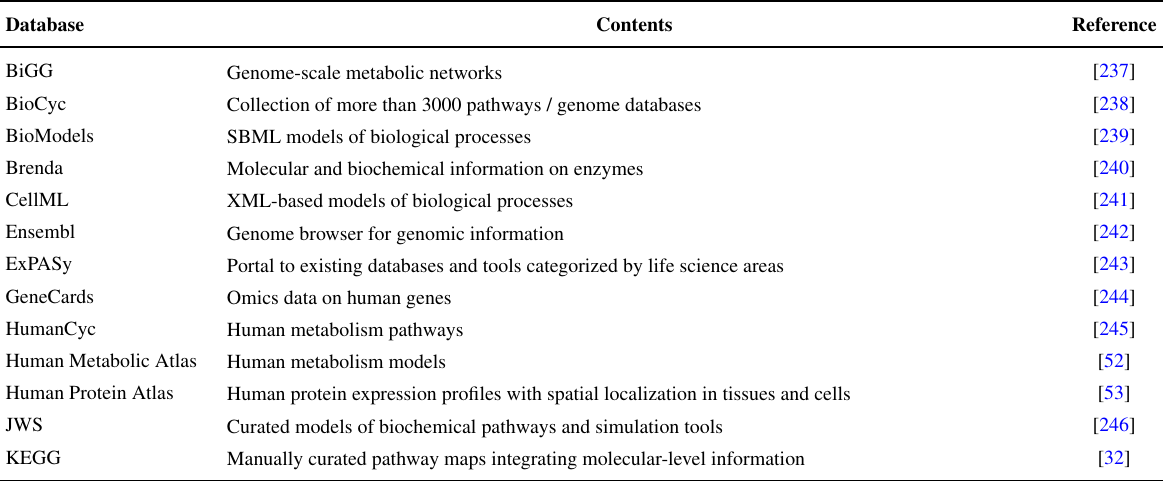
Table 3. Principal databases collecting biological data or metabolic models, fundamental resources for the investigation of